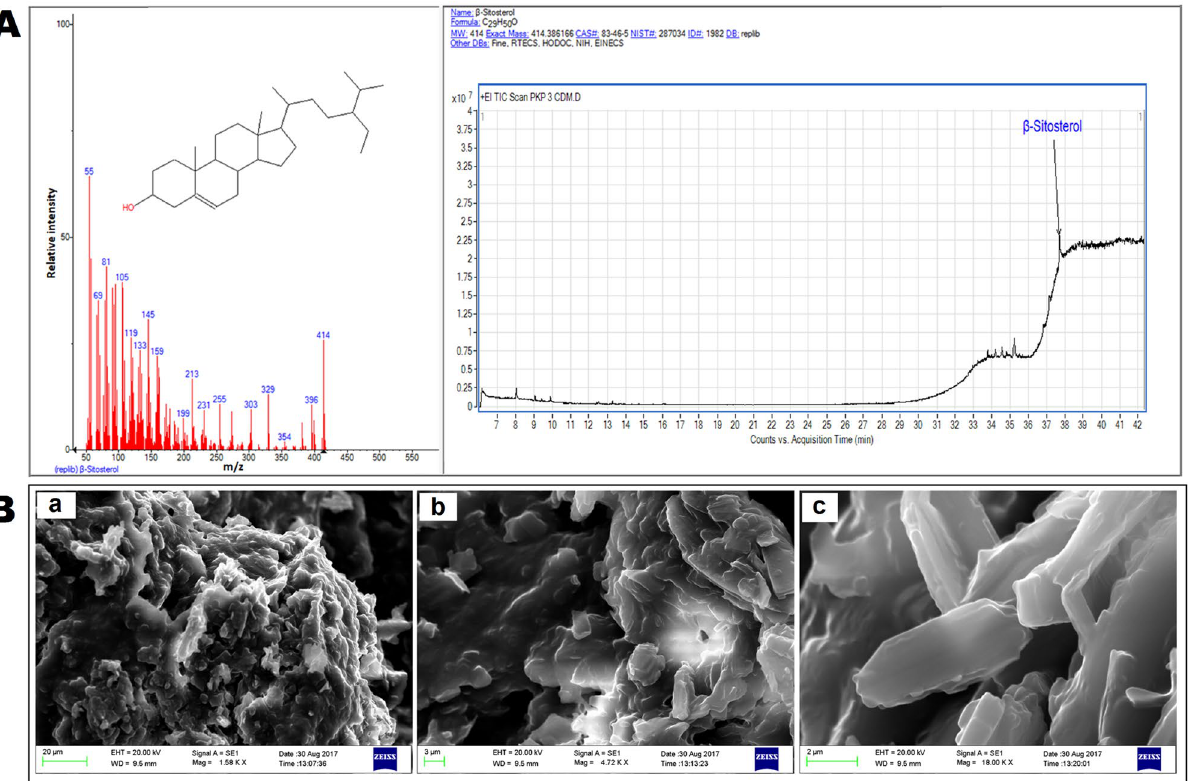
Figure 2. ( A ) Mass spectrum of Corchorus capsularis L. leaf-derived β-sitosterol (β-sitosterol CCL ) is shown in the left panel, and the right panel depicts the chromatogram. GC–MS analysis was performed with a